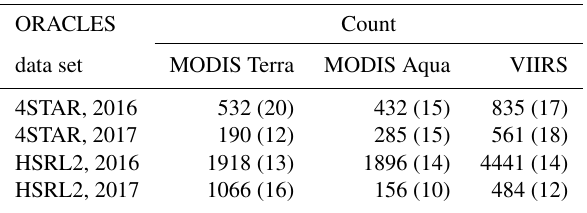
Table 3. Number of individual retrieval matchups (and number of contributing granules, in parentheses) for each satellite sensor and ORACLES data